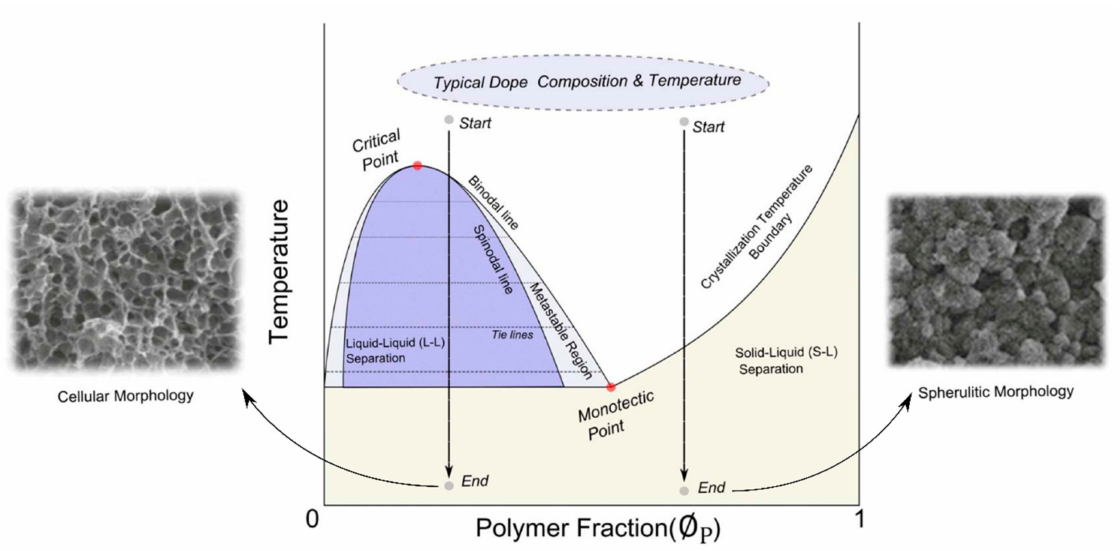
Figure 10. Phase diagram of TIPS process, and comparison of different material morphology obtained. Reprinted with permission from Kim, J.F.; Kim, J.H.; Lee, Y.M.; Drioli, E. (2016) AIChE J.,